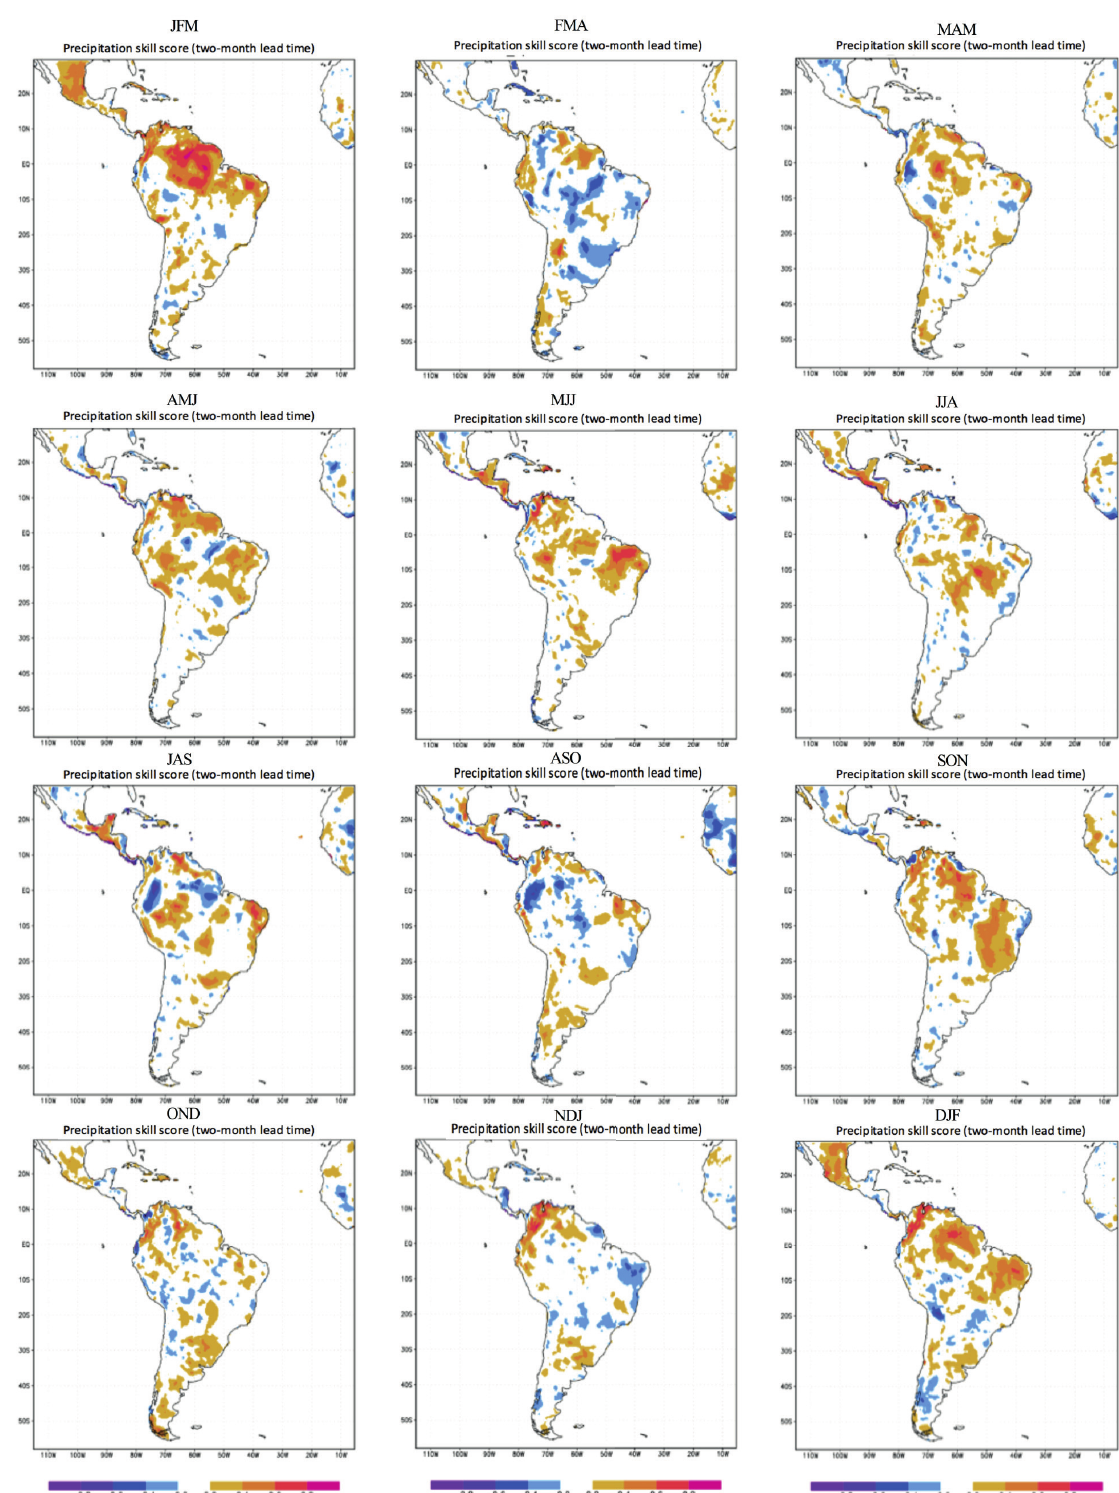
Figure 9. Precipitation skill scores for the Eta model with two-month lead-time forecasts for the seasons: JFM, FMA, MAM, AMJ, MJJ, JJA, JAS, ASO, SON, OND, NDJ, and DJF. The score is